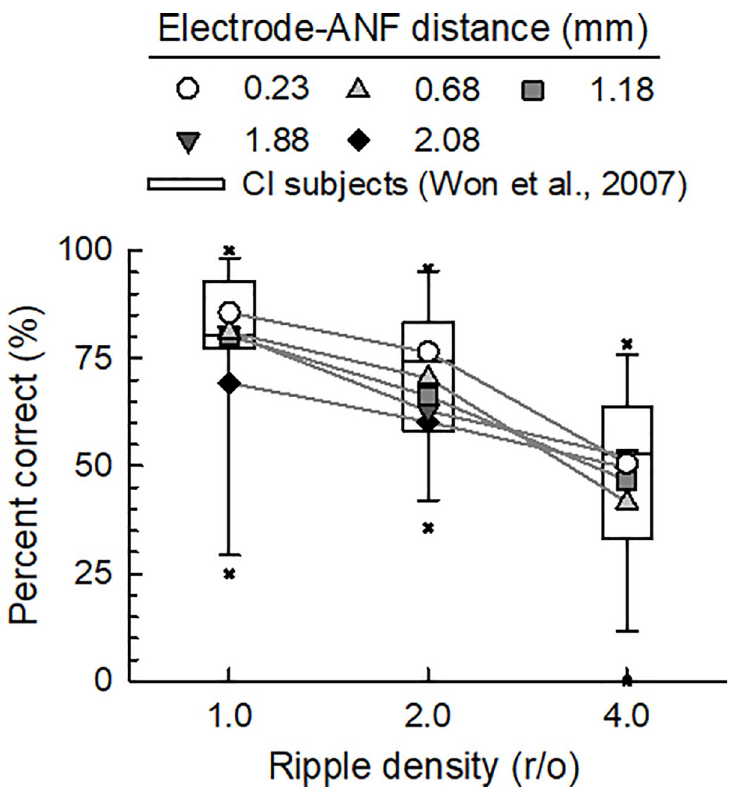
Fig 9. Effect of the electrode–ANF distance on the SRD performance. Each box plots the median, 10th, 25th, 75th, and 90th percentiles of the data of Won et al. (2007) [6] for 15 CI subjects as obtained by the ACE strategy, with the asterisks indicating the outliers. The results obtained by the computational model for the five electrode–ANF distances are indicated by the five different symbols, covering between the 25th and 75th percentiles of the CI subject data for ripple densities of 1.0 and 2.0